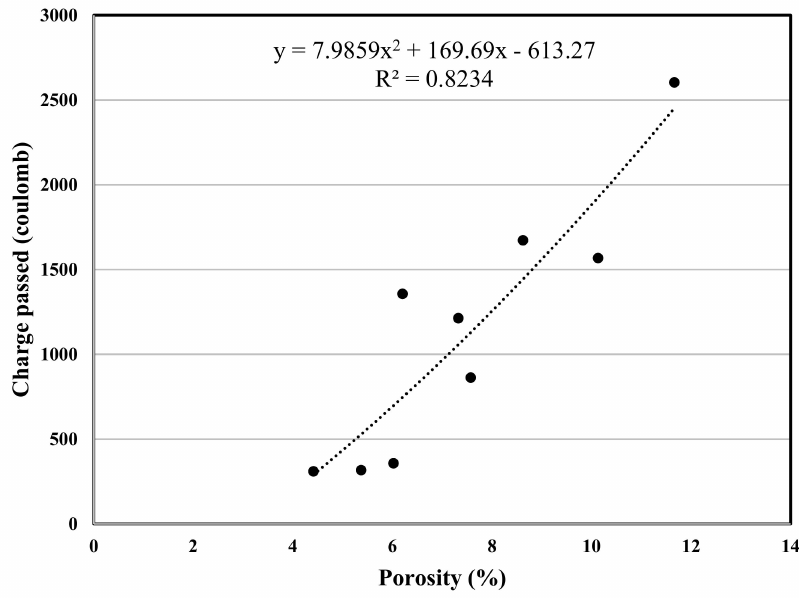
Figure 8. Correlation between porosity and total charge